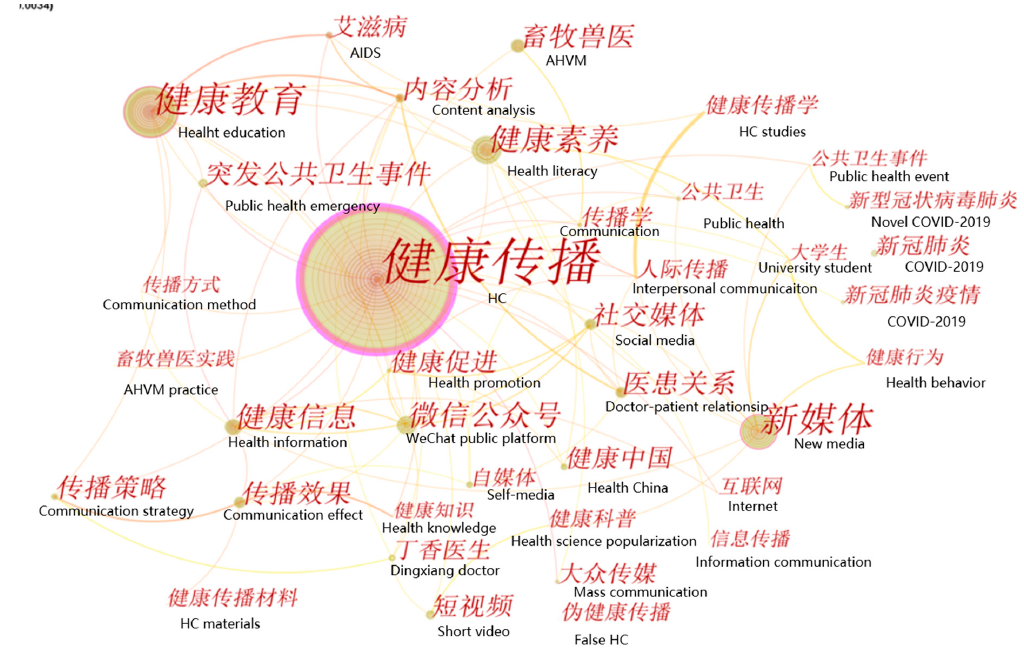
Figure 5. The keyword co-occurrence map for the field of HC from 1992 to 2021 in China. (Note: the authors added English to the map to aid understanding.)